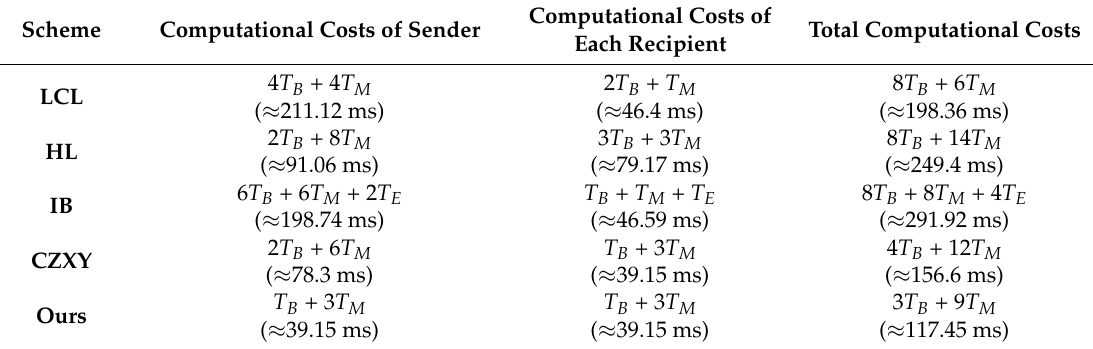
Table 2. Comparisons of computational costs in three-party communication environments.